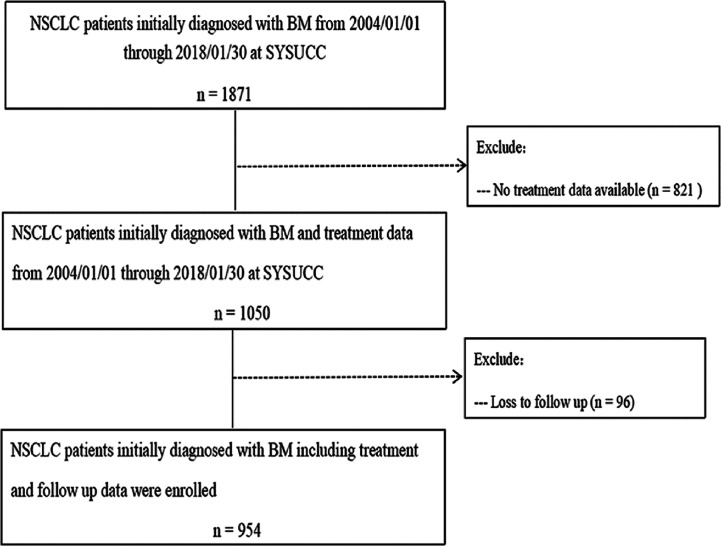
Patient flow chart illustrating selection of the study population. BMs, brain metastases; NSCLC, non-small cell lung cancer; SYSUCC, Sun Yat-Sen University Cancer Center.